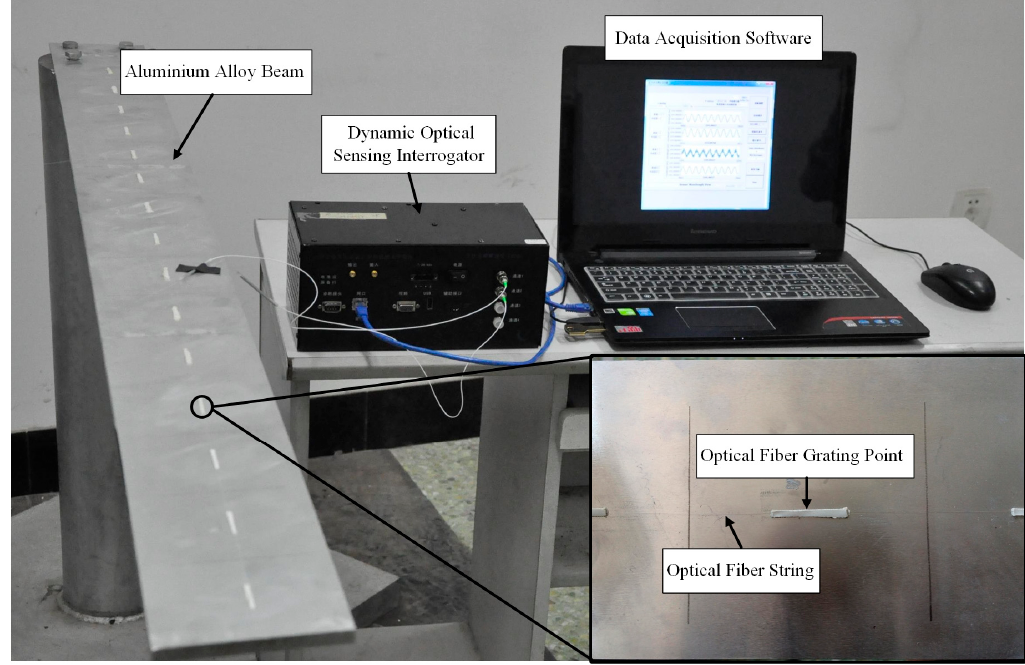
Figure 14. The entire experimental setup of the study.